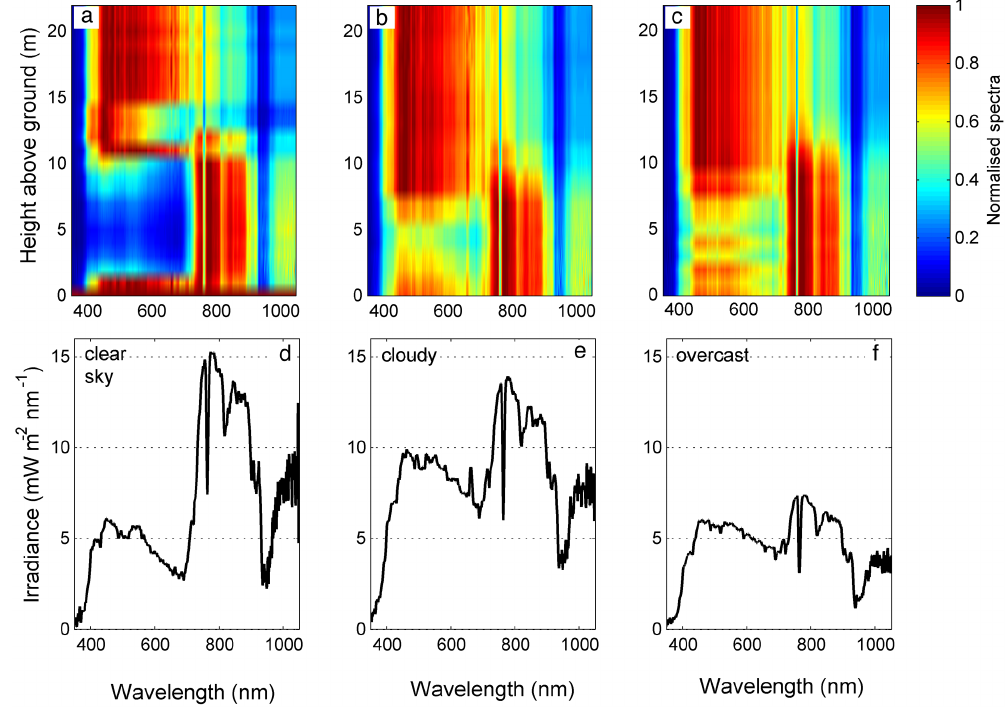
Figure 3. Vertical profile of spectral distribution of solar radiation traversing the forest canopy on a clear, cloudy and overcast day. (a) vertical profile on the clear day; (b) vertical profile on the cloudy day; (c) vertical profile on the overcast day. For the visualisations the data are normalised on a scale from 0 to 1. (d) , (e) and (f) show the spectral distribution at 2m above ground in absolute terms, showing the exact energy distribution across all